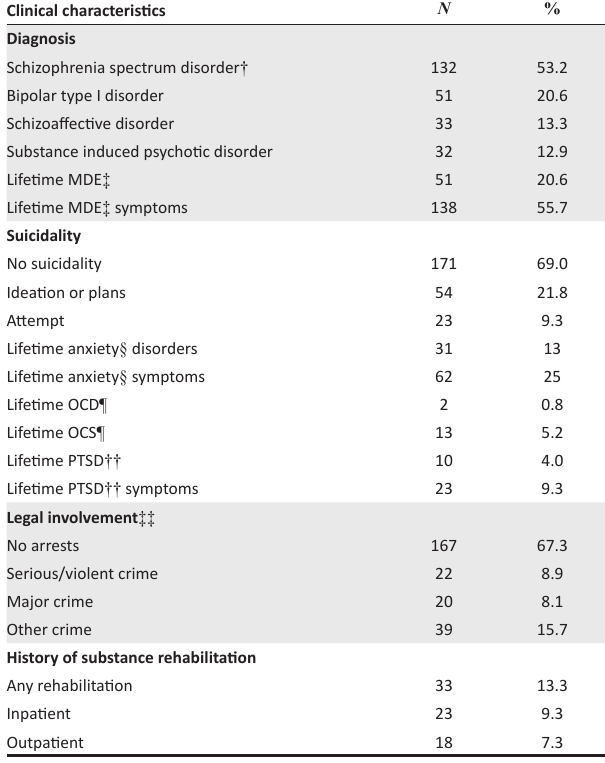
TABLE 2: Sample clinical characteristics ( N = 248).